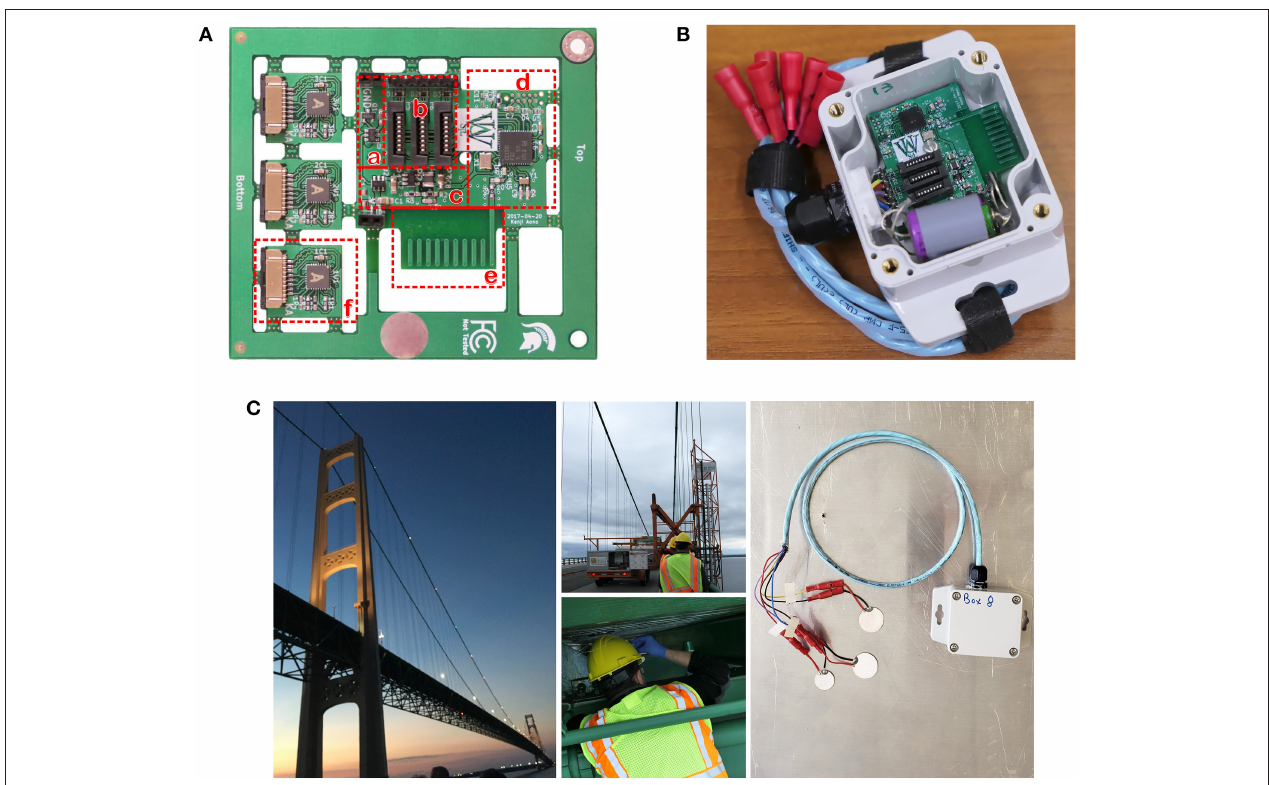
FIGURE 8 | Second version of the sensor platform, deployed for testing in spring of 2017 and still responding in autumn of 2018. (A) Custom PCB with (a) Sleep-mode timer, (b) Connectors for PFG and piezo, (c) Battery Management, (d) RF MCU, (e) PCB Antenna, and (f) PFG modules. (B) Weatherproof housing with cabling, a batteries mounted, and the RF PCB installed. PFG module not mounted, and the lid is removed for this image. (C) Pictures showing the Mackinac Bridge, installation of the second version, and a mock-up of how the sensor platform is affixed to steel